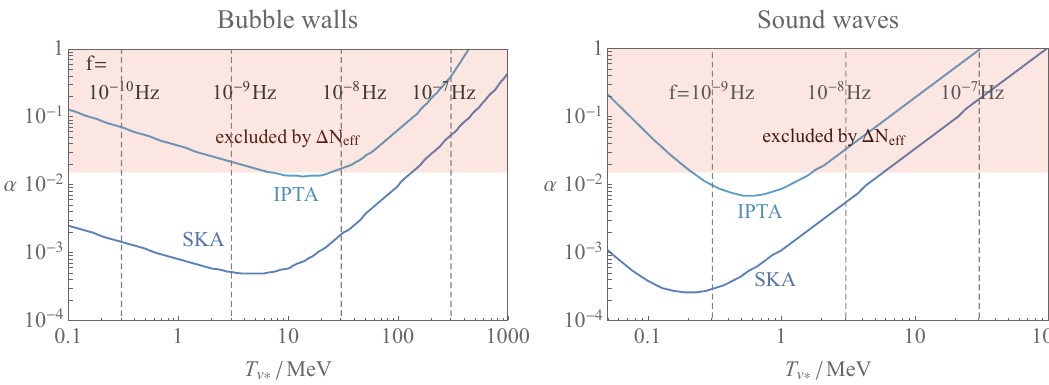
Figure 10 . The minimum value of α that leads to a gravitational wave signals that can be detected at SKA and IPTA as a function of the visible sector temperature at the time of the transition . Results are shown for runaway bubble walls in an effective vacuum with β/H = 10 (left) T v ∗ ∗ and sound waves from a phase transition that is strong (but without runaway bubble walls) with = 100 (right). The corresponding peak frequencies of the emitted gravitational wave signal β/H ∗ are also indicated. We assume the hidden sector states decay to light hidden sector states, and the effects of these on the number of relativistic degrees of freedom constrains α < 0 . 015. Once parameterised in terms of β/H , α , and T v the results are independent of the particular hidden ∗ ∗ sector considered. Constraints from BBN mean we do not expect to see a signal from a hidden (cid:31) 10 MeV, which means that a signal sector at the same temperature as the visible sector for T v ∗ 9 Hz would be a strong indication of a signal originating in a cold with a peak frequencies (cid:31) 10 − hidden sector (even allowing for freedom in β/H ∗